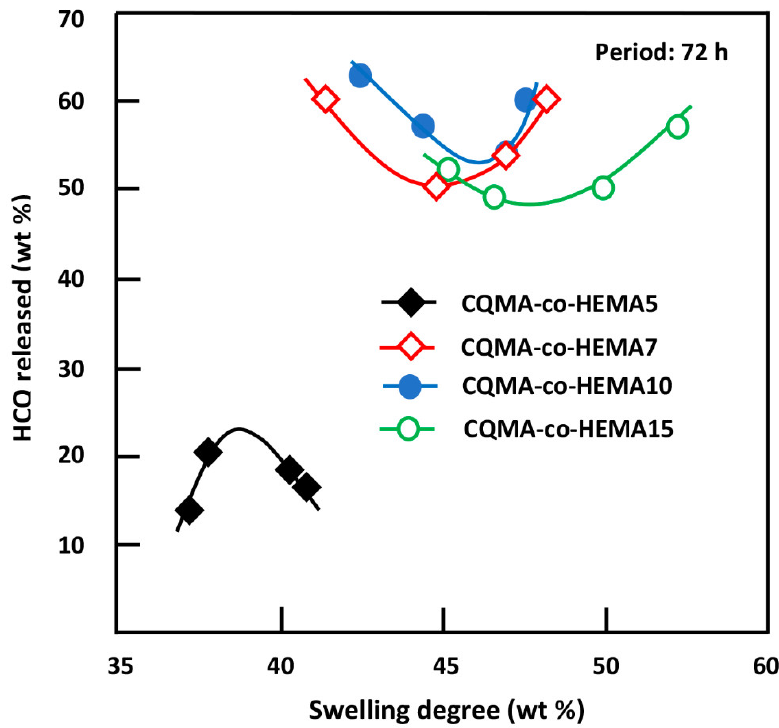
Figure 17. Release behavior of HCQ versus the swelling capacity of CQMA- co -HEMA systems in different pH media.